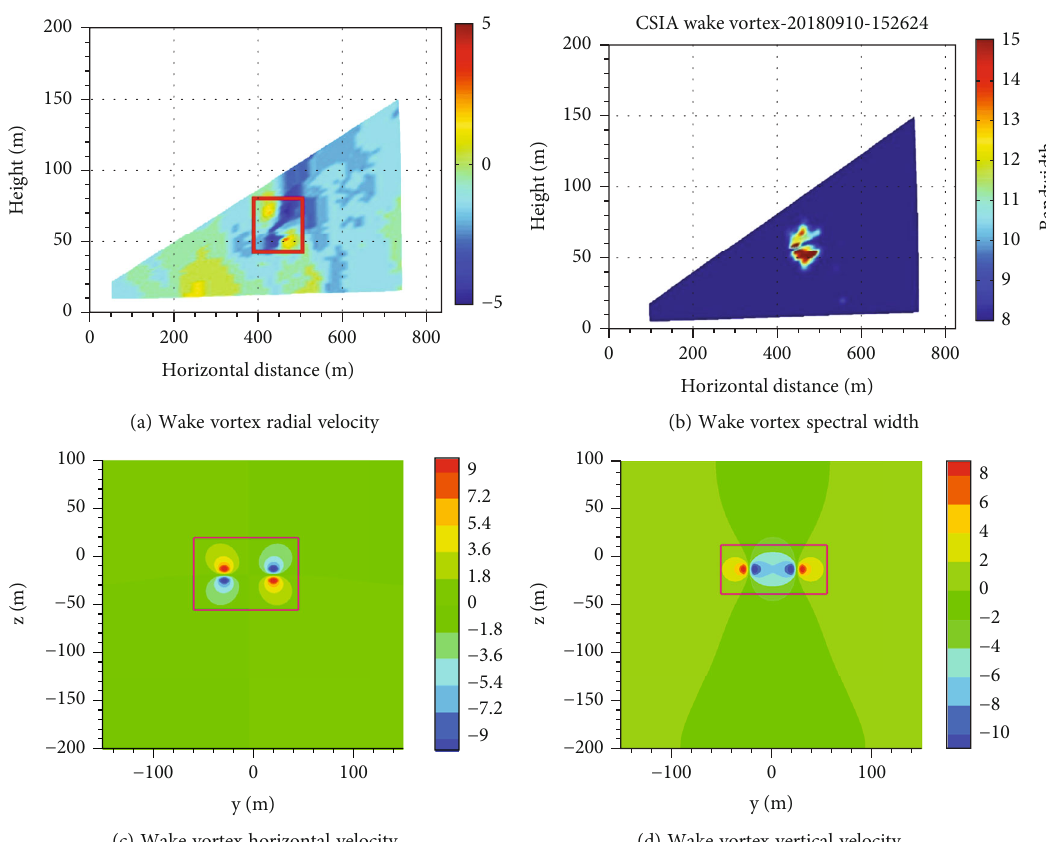
Figure 8: Comparison of the initial state of the wake vortex between radar detection and numerical simulation